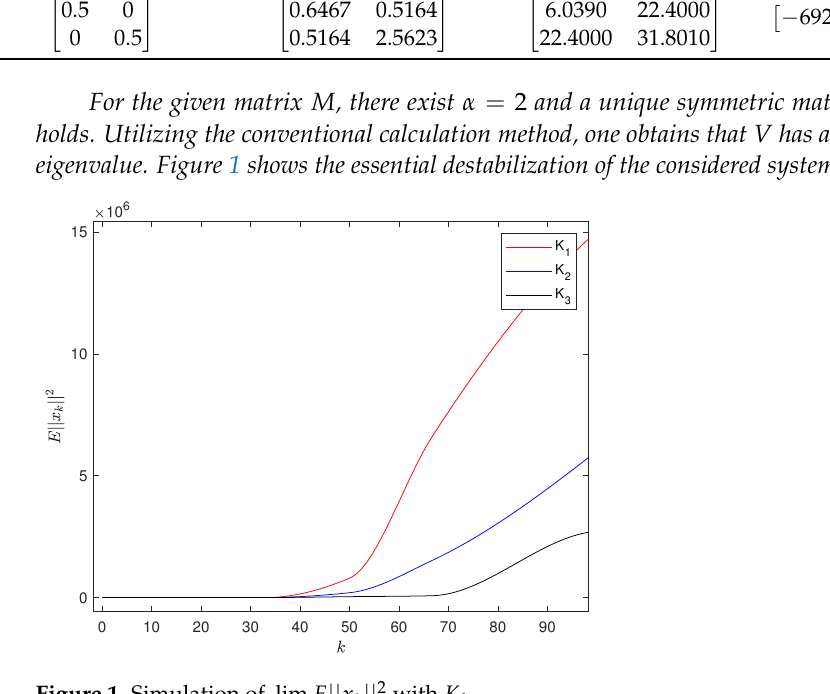
E || x k || 2 with K 1 k → ∞